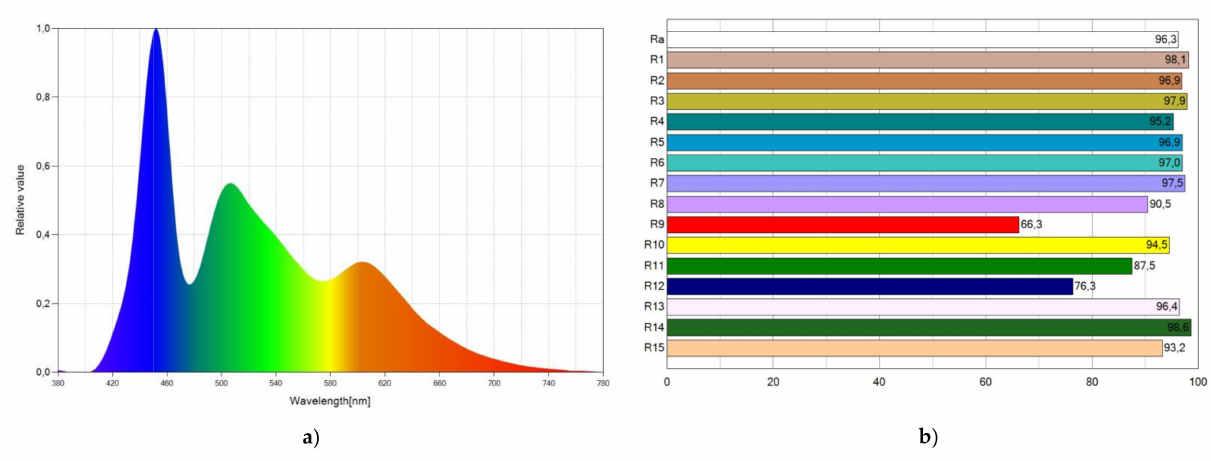
Figure 7. Spectral power distribution (SPD) chart ( a ) and CRI points ( b ) of WLED-11.